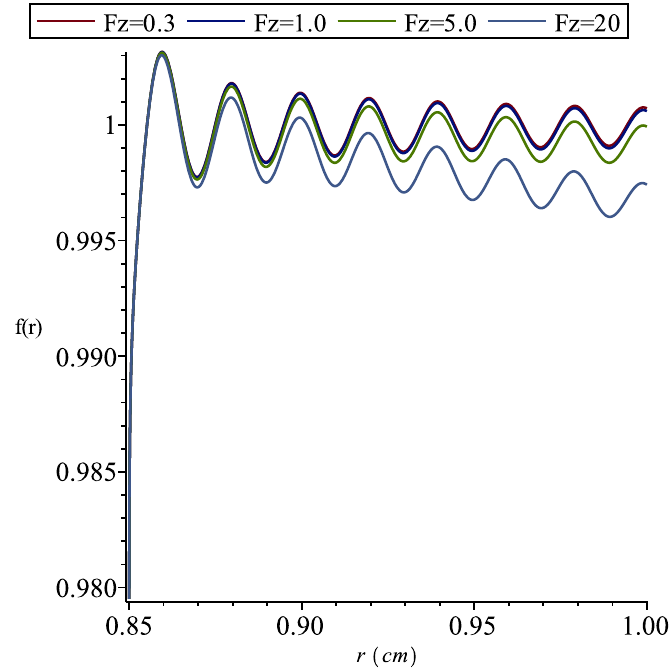
Figure 5. f versus r for α = − 100,000 in level set function φ , R i = 0.85 cm is the radial value at the gas/liquid interface.